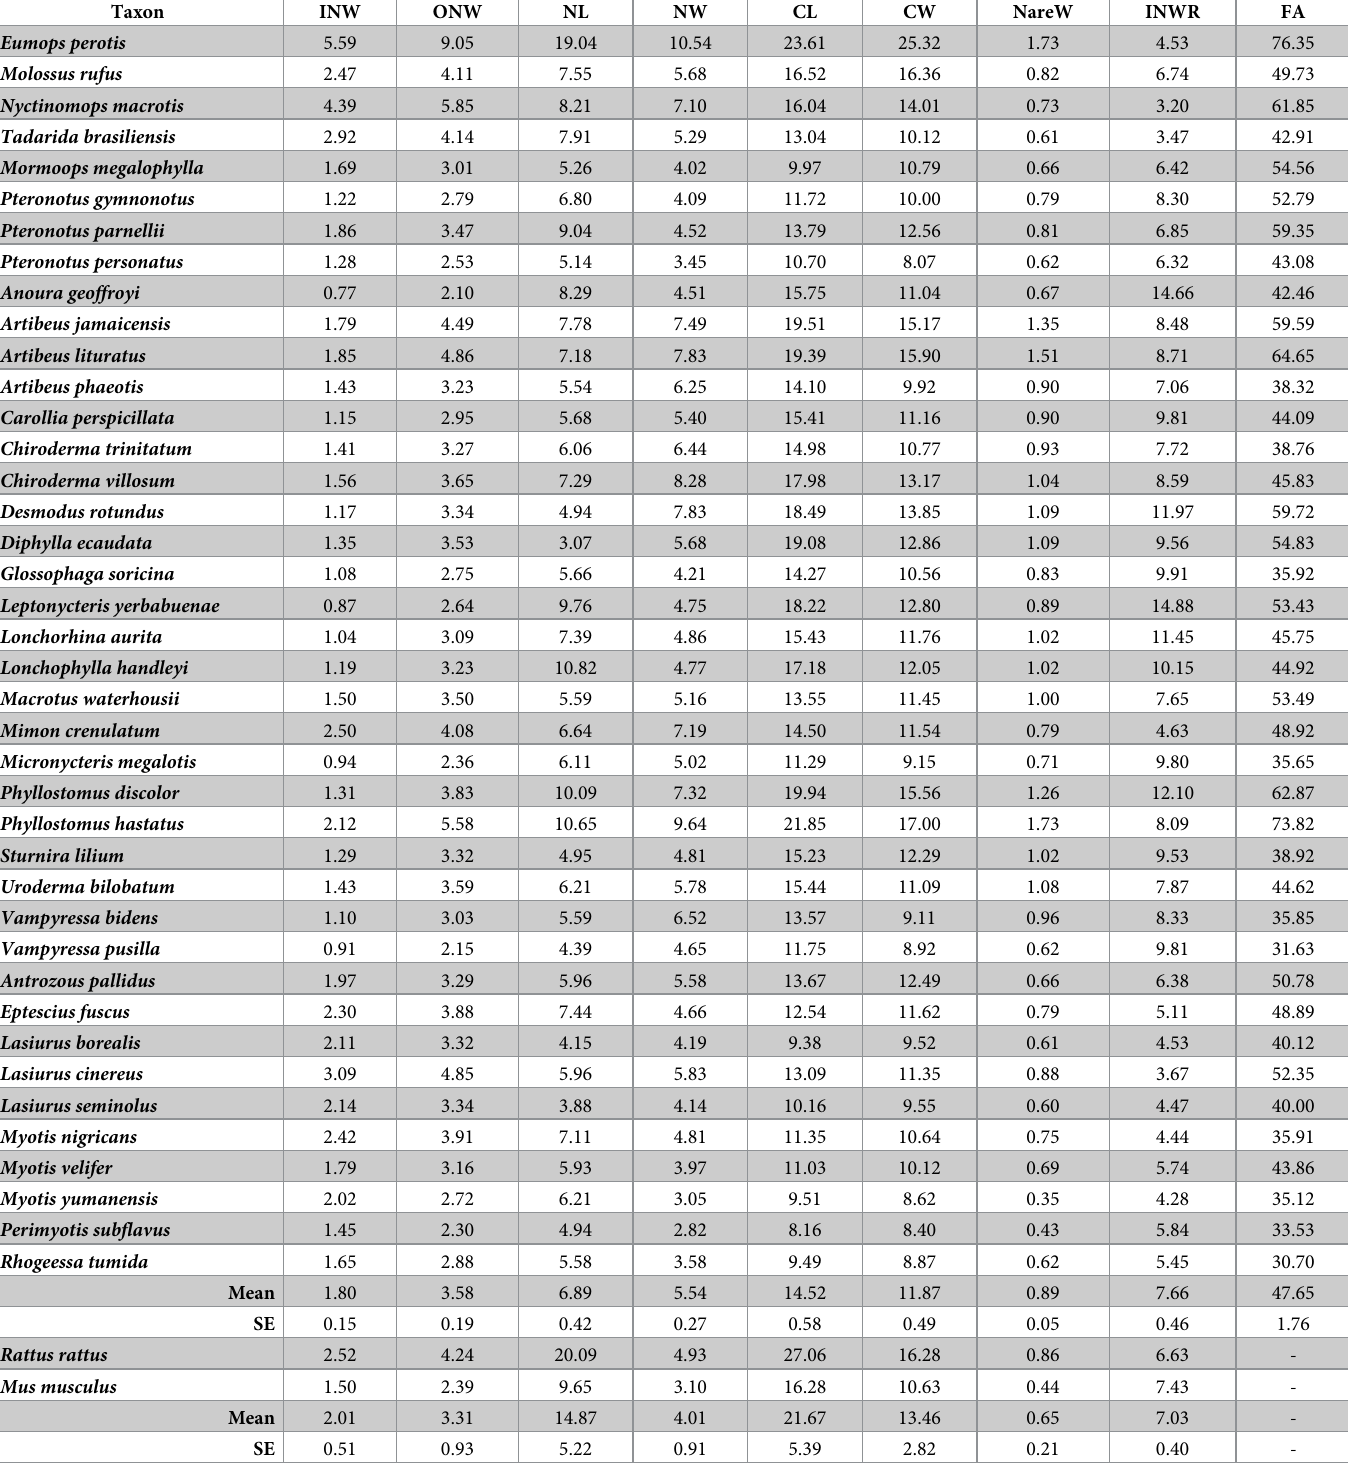
Morphology character abbreviations are described in Table 1. All measurements except INWR are in